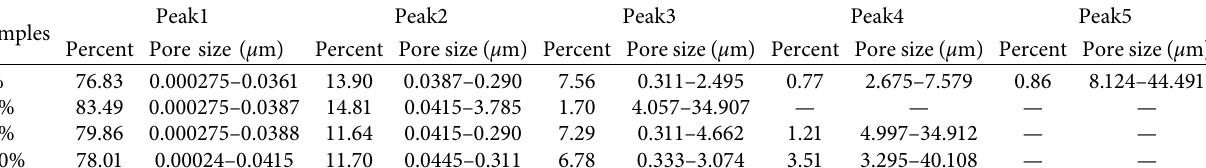
Table 5: Nuclear magnetic resonance T 2 spectrum areas and pore size distribution of ASC.